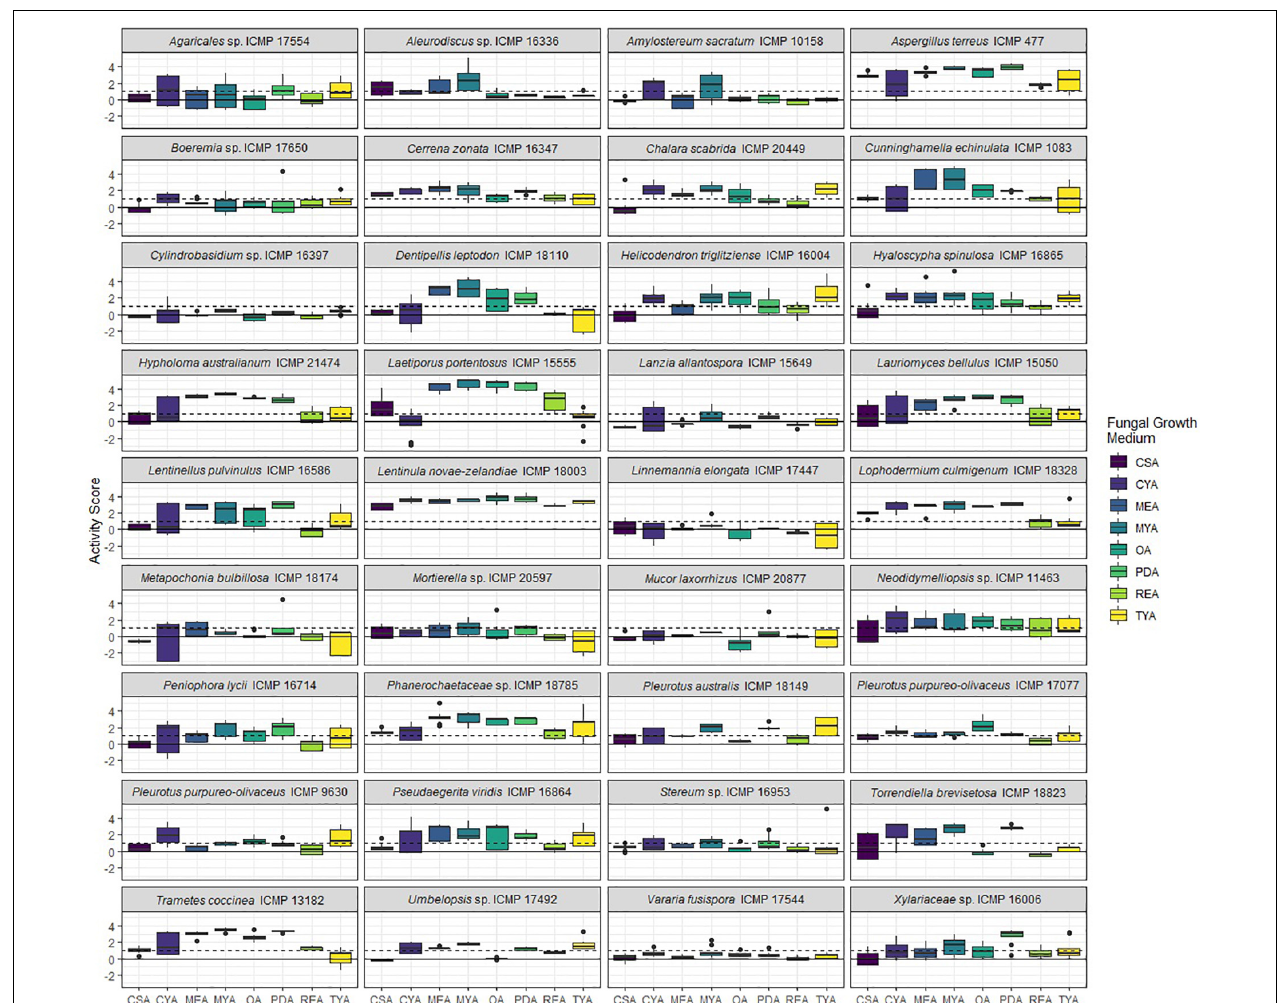
FIGURE 3 | Antibacterial activity of ICMP fungal isolates against Mycobacterium abscessus BSG301 when grown on different media. Data is presented as box and whisker plots of activity scores. The solid line shown at 0 is the median control value while the dotted line at 1 is the activity threshold. Scores above 1 correspond to a > 90% reduction in bacterial bioluminescence compared to the corresponding no-fungi control. Similarly, an activity score above 2 means corresponds to a > 99% reduction. CSA, Czapek Solution Agar; CYA, Czapek Yeast Extract Agar; MEA, Malt Extract Agar; MYA, Malt Yeast Extract Agar; OA, Oatmeal Agar; PDA, Potato Dextrose Agar; REA, Rice Extract Agar; TYA, Tryptone Yeast Extract Agar. Boxes are upper and lower quartiles with median shown. The whiskers extend up to 1.5 × the inter-quartile range and any dots beyond those bounds are